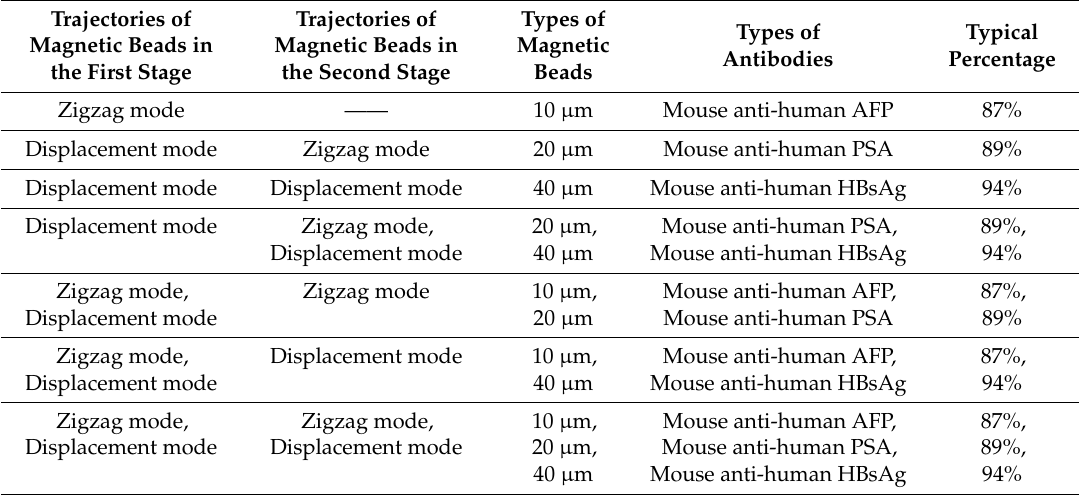
Table 1. Recognition of the types of antibodies based on the trajectories of the magnetic